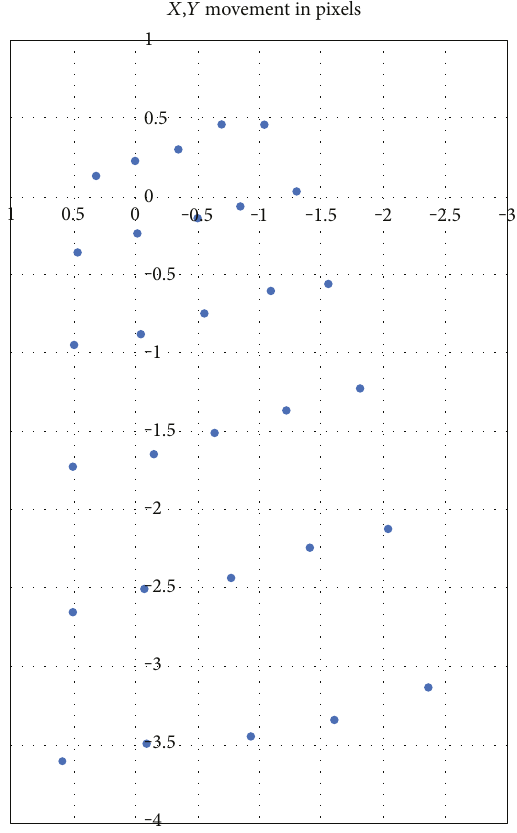
Figure 15: An example of a surface movement observed by 30 (5 × 6) targets (see Figure 16). Comparing two images, with an average tilt change of about 1 mm. A change of 0.1 pixel at targets is detectable (strongly above the noise level), allowing a z -accuracy of about 0.2mm on level 1 Figure 16: A testing setup: a paper with 30 (5 × 6) targets was attached to a fl at panel. This panel can be moved using a set of accurate spacers (at a, b, c, and d), allowing us to test global movements with a high level of accuracy.